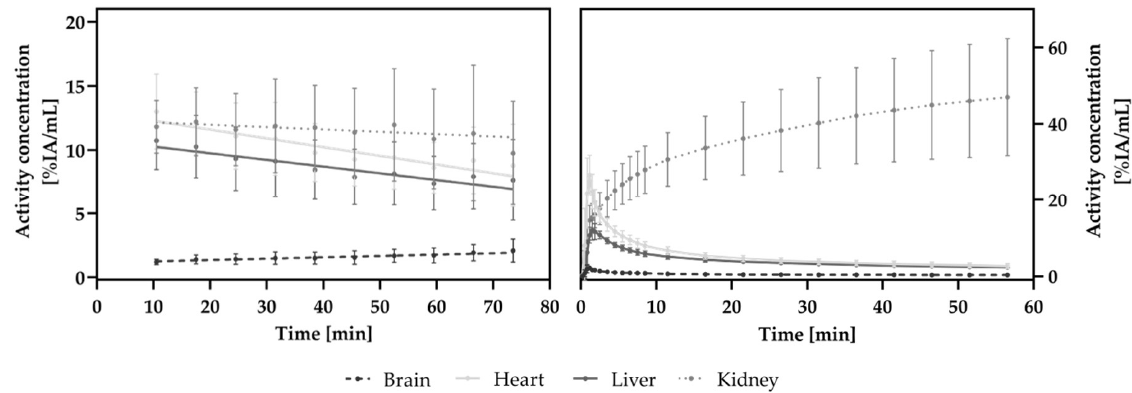
Figure 7. Time-activity curves based on the analysis of PET data of the HET-CAM ( left ) and mouse ( right ) models. The activity concentration of the organs-of-interest (brain, heart, liver, and kidneys) was monitored over a 60 min PET scan. In both models, only low levels of radioactivity are seen in the brain. For heart and liver, a decrease in signal is observed after an initial increase. As measurements in the HET-CAM model were not started until approximately 10 min after injection, there is no increase mapped in the graph. Heart and liver are often correlated with the blood pool. The activity concentration in the kidneys of the chick embryos remained constant, whereas in the mouse model, the activity concentration increased during the